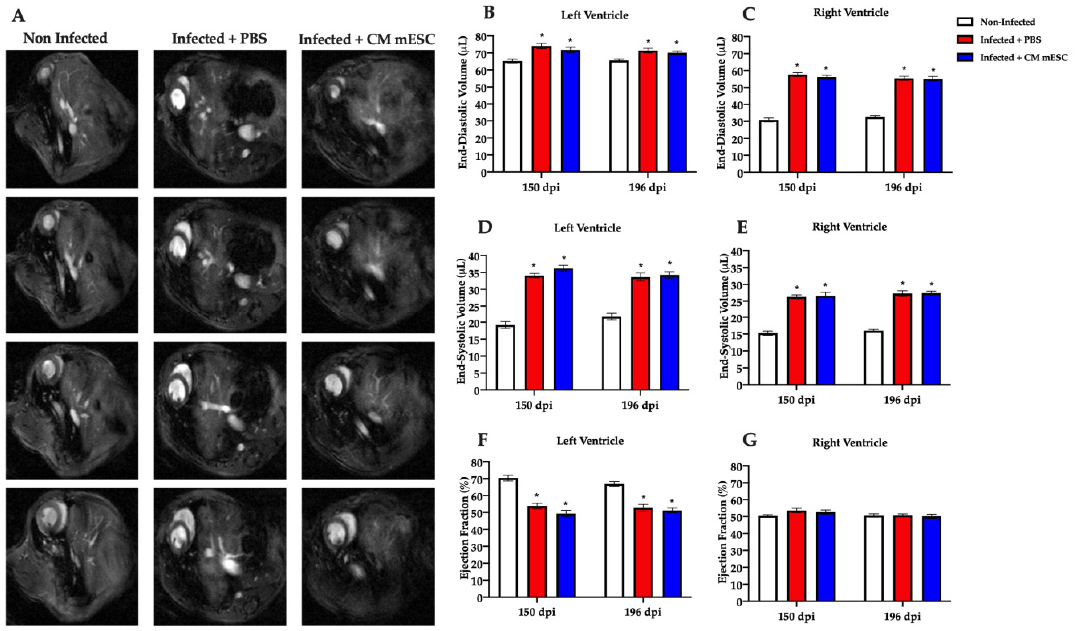
Figure 3. Cardiac function evaluation by magnetic resonance imaging (MRI). Measures were performed 150 and 196 (corresponding to 45 days after the injection of CM-mESC or PBS in infected mice) days post-infection (dpi). ( A ) Representative images in diastole. A sequence of images from the same animal on day 196 is shown in each column. ( B – G ) Analysis of left and right ventricle end-diastolic volume (EDV) ( B , C ), end-systolic volume (ESV) ( D , E ), and ejection fraction (EF) ( F , G ), respectively. Two away ANOVA with Tukey’s comparison test: * p < 0.05 compared to the Non-infected group. Data shown as mean ± standard error of mean; n = 13 for Non-infected group, n = 7 for Infected + PBS group, and n = 7 for Infected + CM-mESC group. CM-mESC—cardiomyocytes derived from mouse embryonic stem cells.